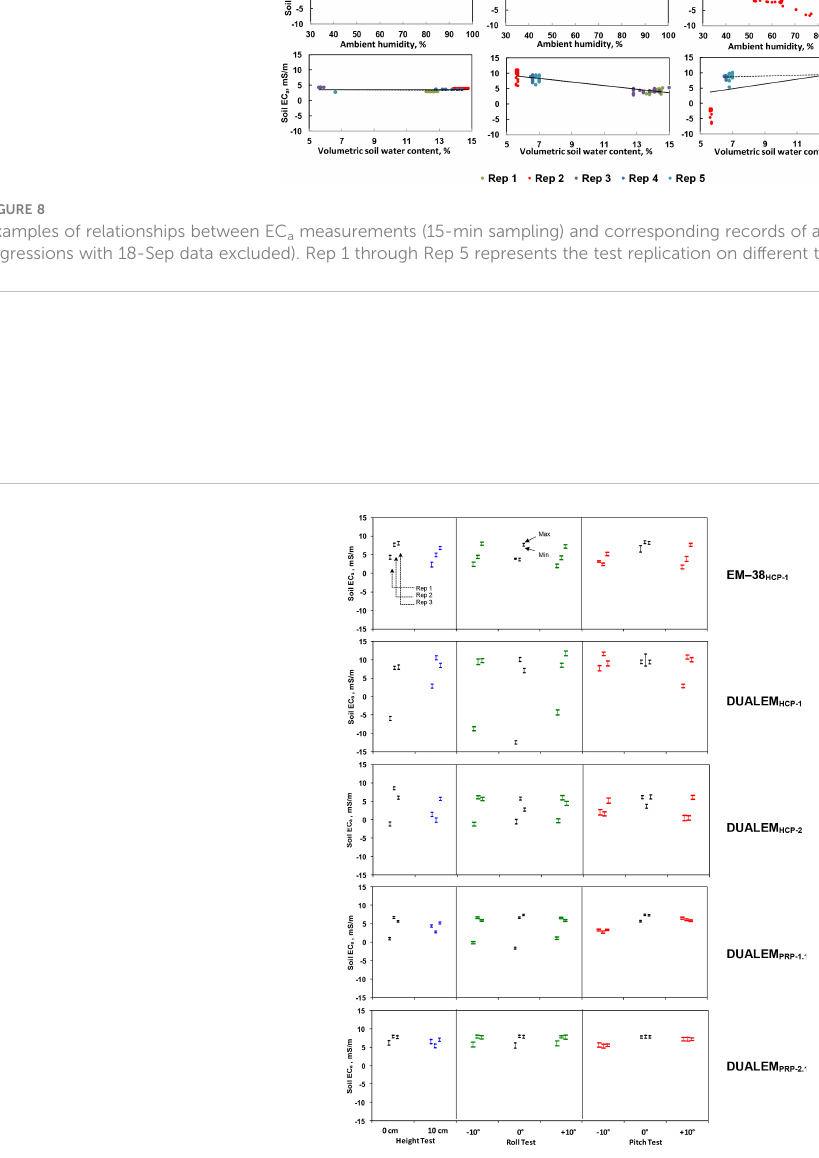
FIGURE 9 The range (minimum and maximum) of operational tests for each recorded measurement. Rep 1 through Rep 3 represents the test replication on different test events. Different colors represent different operation tests in relative to the normal position of